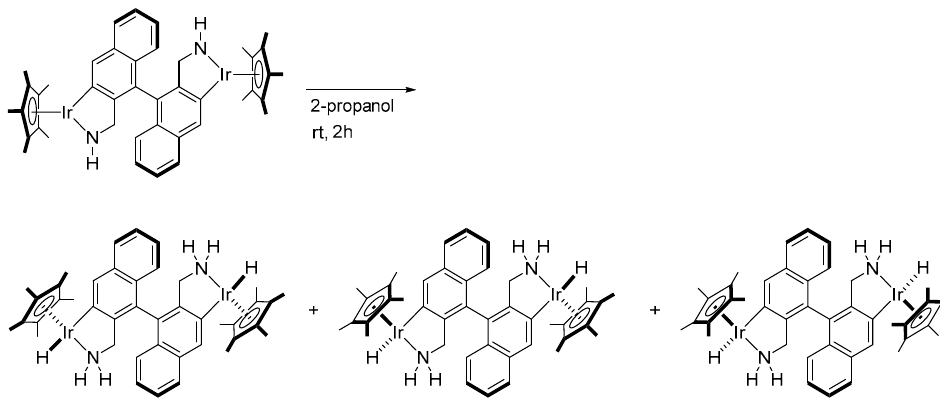
Figure 1. Selected 1 H NMR spectrum of 6 in CD 2 Cl 2 .